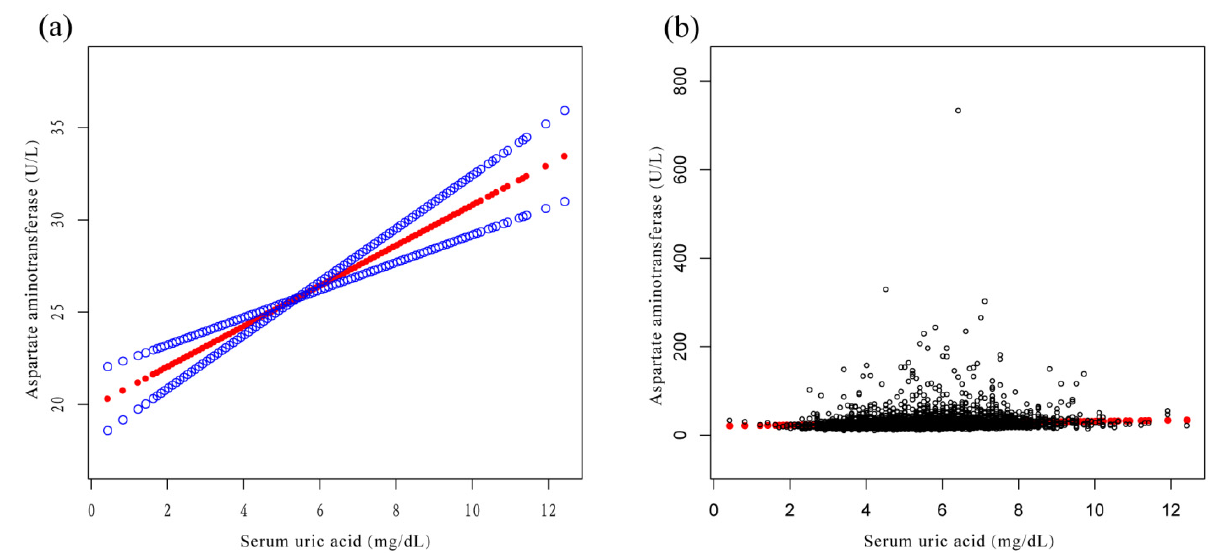
Figure 3. Relationship between serum uric acid and liver enzymes. ( a ) Relationship between serum uric acid and aspartate aminotransferase (R 2 = 0.077). The red line represents the fitted curve, and the blue line represents the 95% confidence interval. ( b ) Each black point represents a sample, and the red line represents the fitted curve.